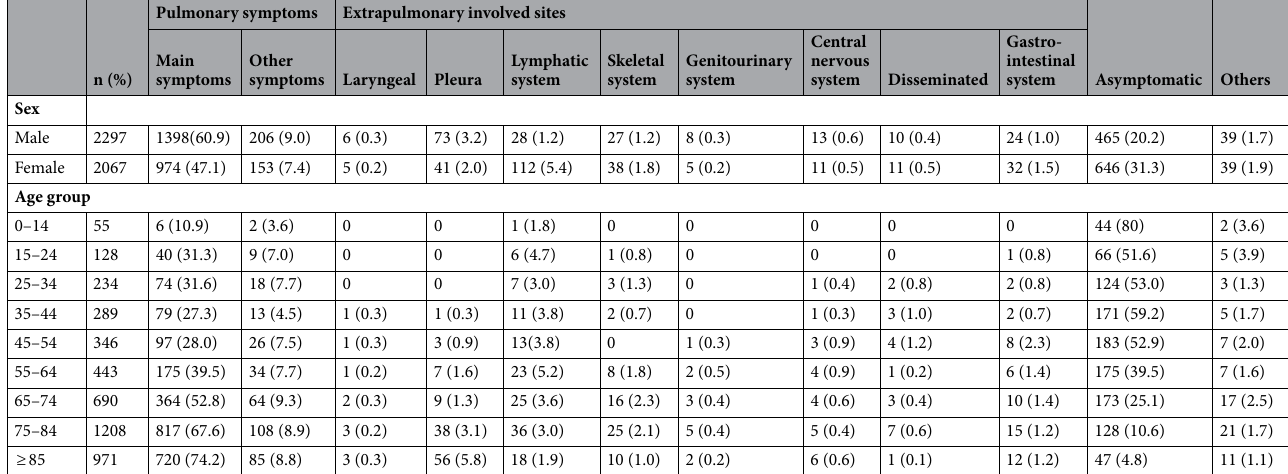
Table 3. Clinical symptoms of 4364 reported TB infections by sex and age group, Nagasaki Prefecture, 2007 to